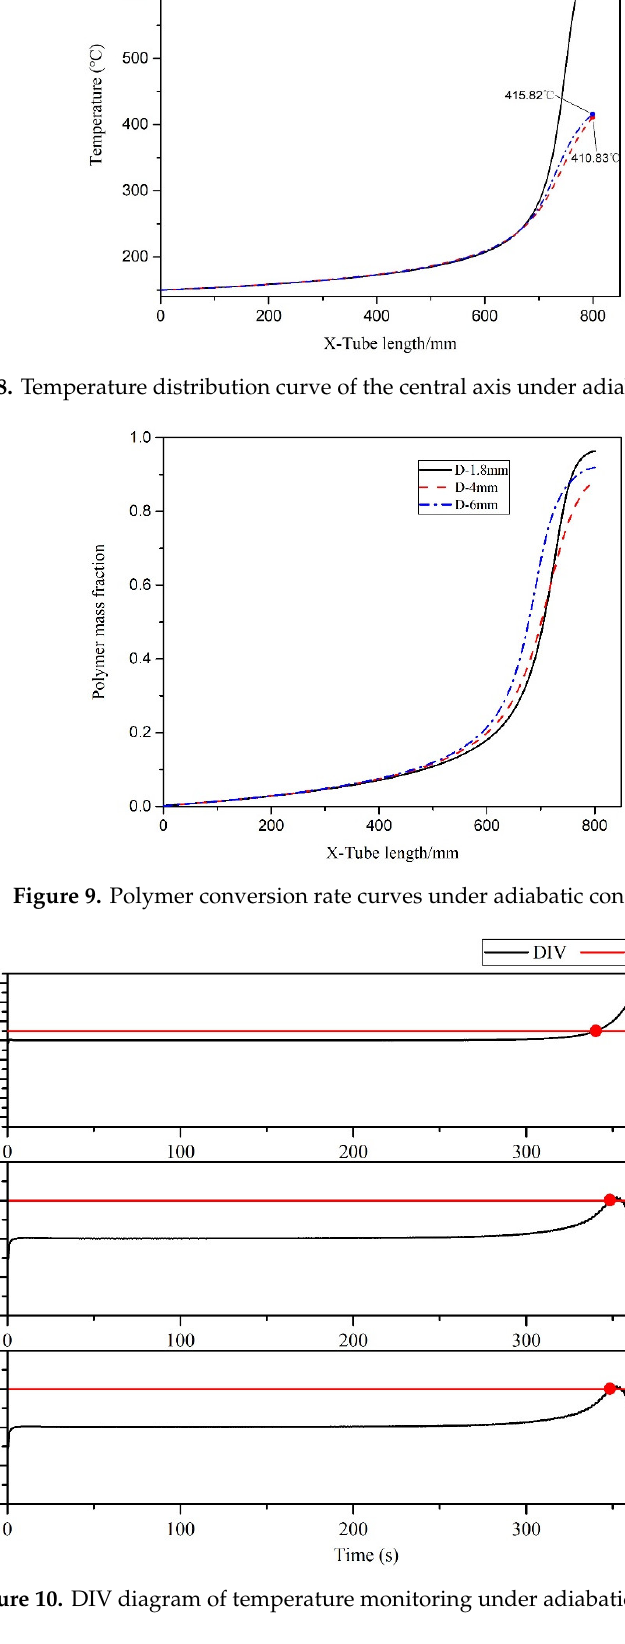
Figure 10. DIV diagram of temperature monitoring under adiabatic conditions.